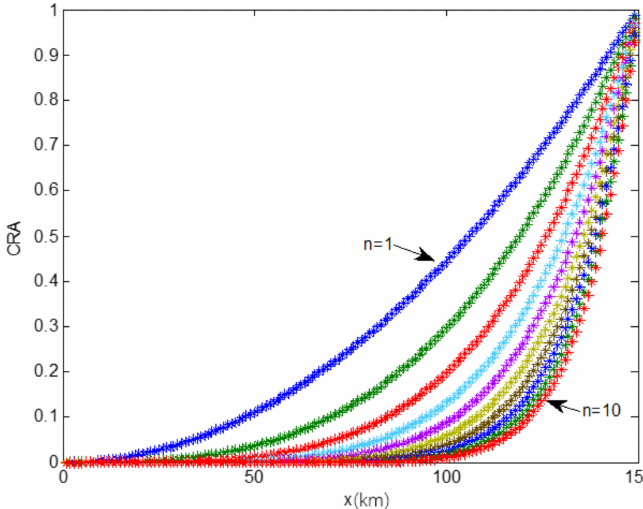
Figure 2. The plot of CRA 0 − 1 ( x ) at Q = 150, n = 1, . . . ,